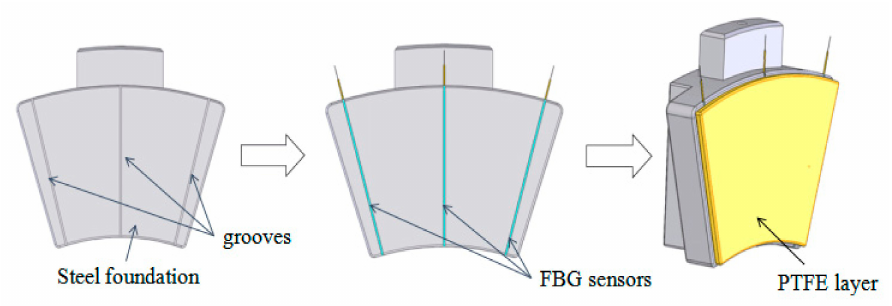
Figure 5. Installation process flow of FBG temperature sensors for thrust sliding bearing